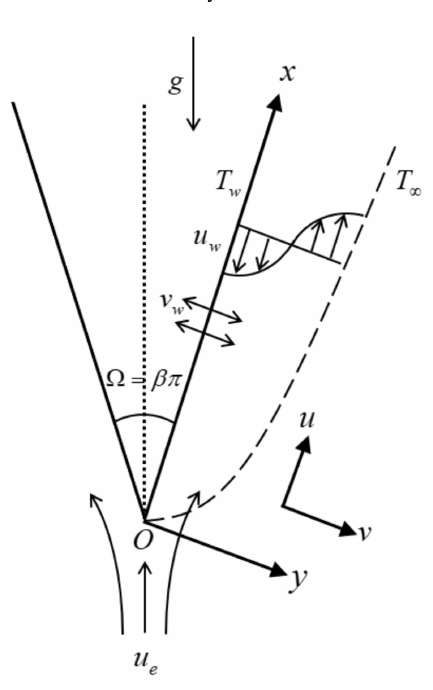
Figure 1. The physical